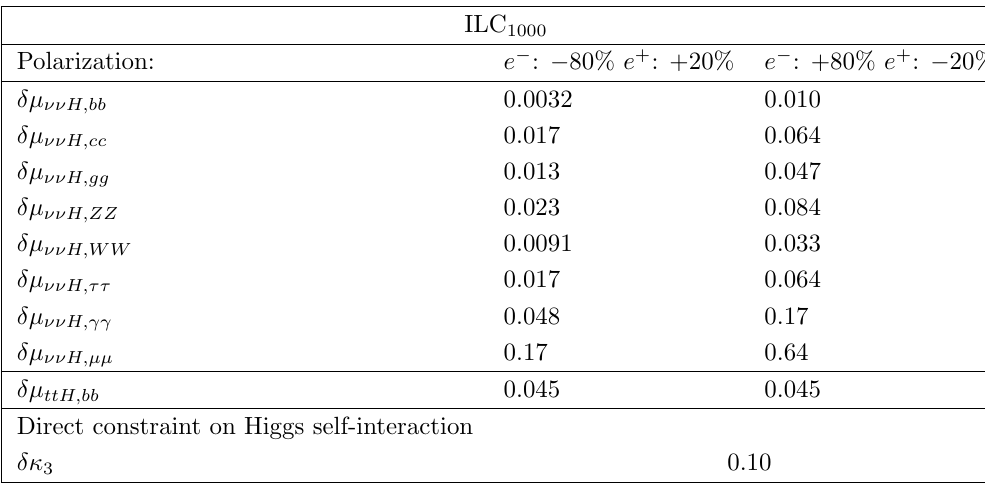
Table 22 . Inputs used for ILC projections at the 500 and 1000 GeV energy stages and two polar- isations. All uncertainties are given as fractional 68% CL intervals and are taken to be symmetric. The upper limits are given at 68%